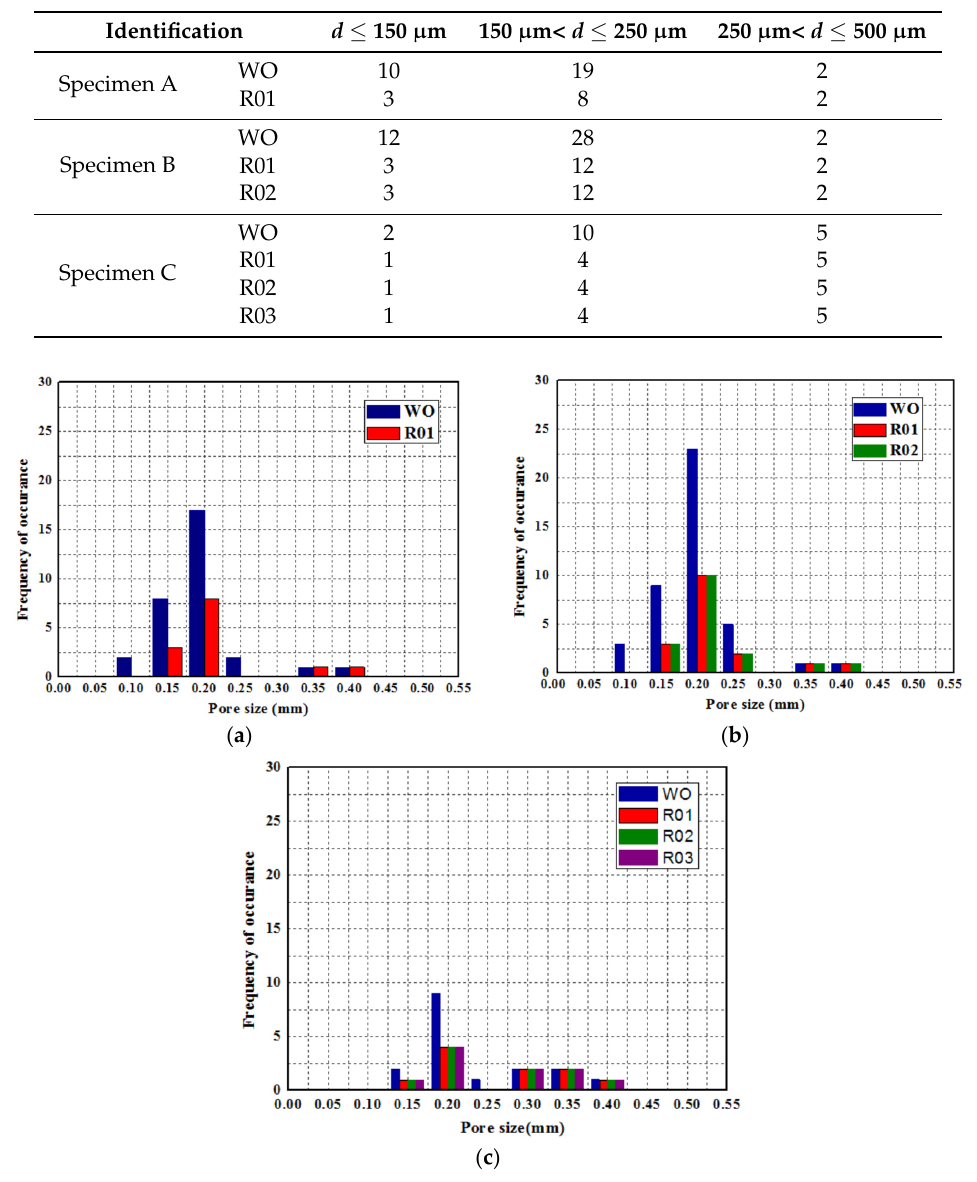
Figure 5. Effect of TIG dressing on porosity removing and distribution: (a) specimen A; ( b ) specimen B; ( c ) specimen C.